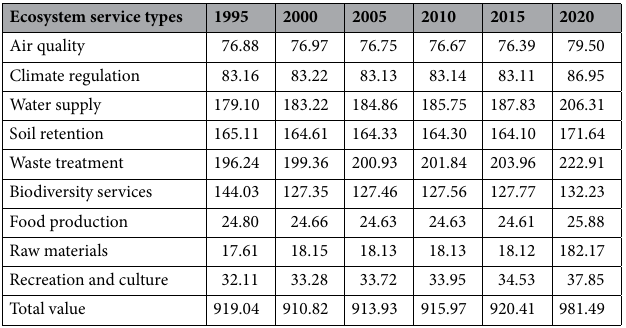
Table 6. The ecosystem service values (ESVs) from 1995 to 2020 (unit: 2020 US$ Billion).